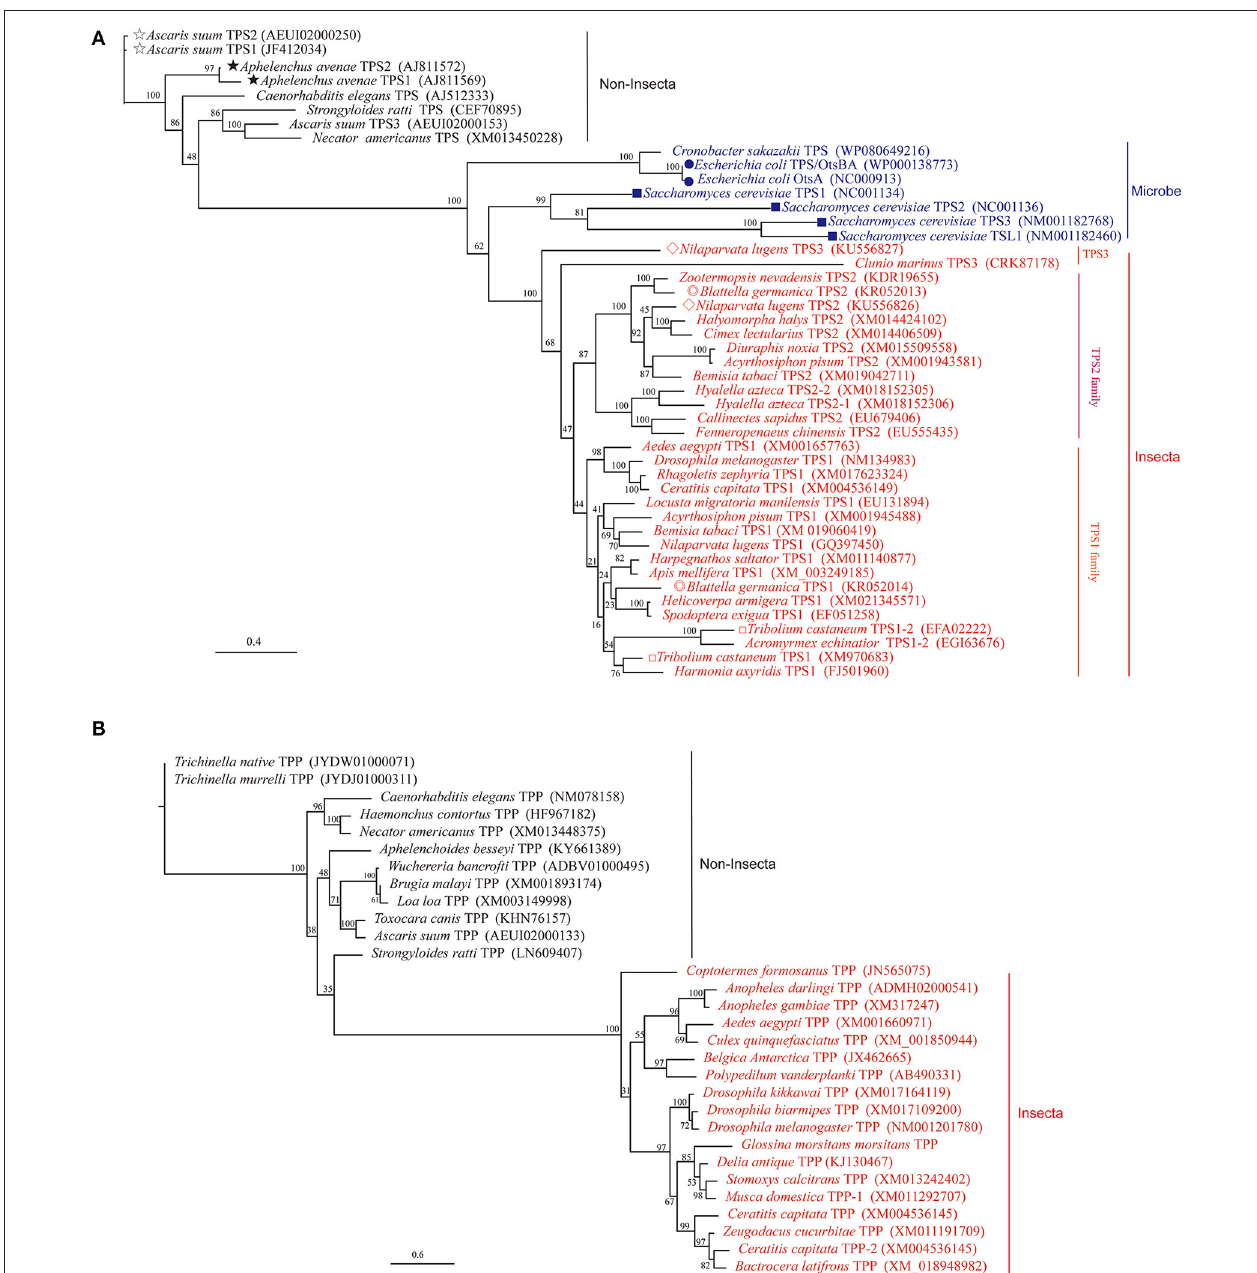
FIGURE 1 | Phylogenetic analysis of insect TPS and TPP based on their amino acid sequences. Full-length amino acid sequences were aligned using Mega 6.0 and to the ML phylogenetic tree (TPS for A ; TPP for B ) was performed using PhyML with the model of WAG (Guindon et al., 2005). A bootstrap analysis was carried out and the robustness of each cluster was verified in 1,000 replications. Some species have more than two TPS proteins have marked by different form front of species name (A) . The monophyly of insect TPP and TPS is well supported, but the monophyly of non-insect and microbe is not